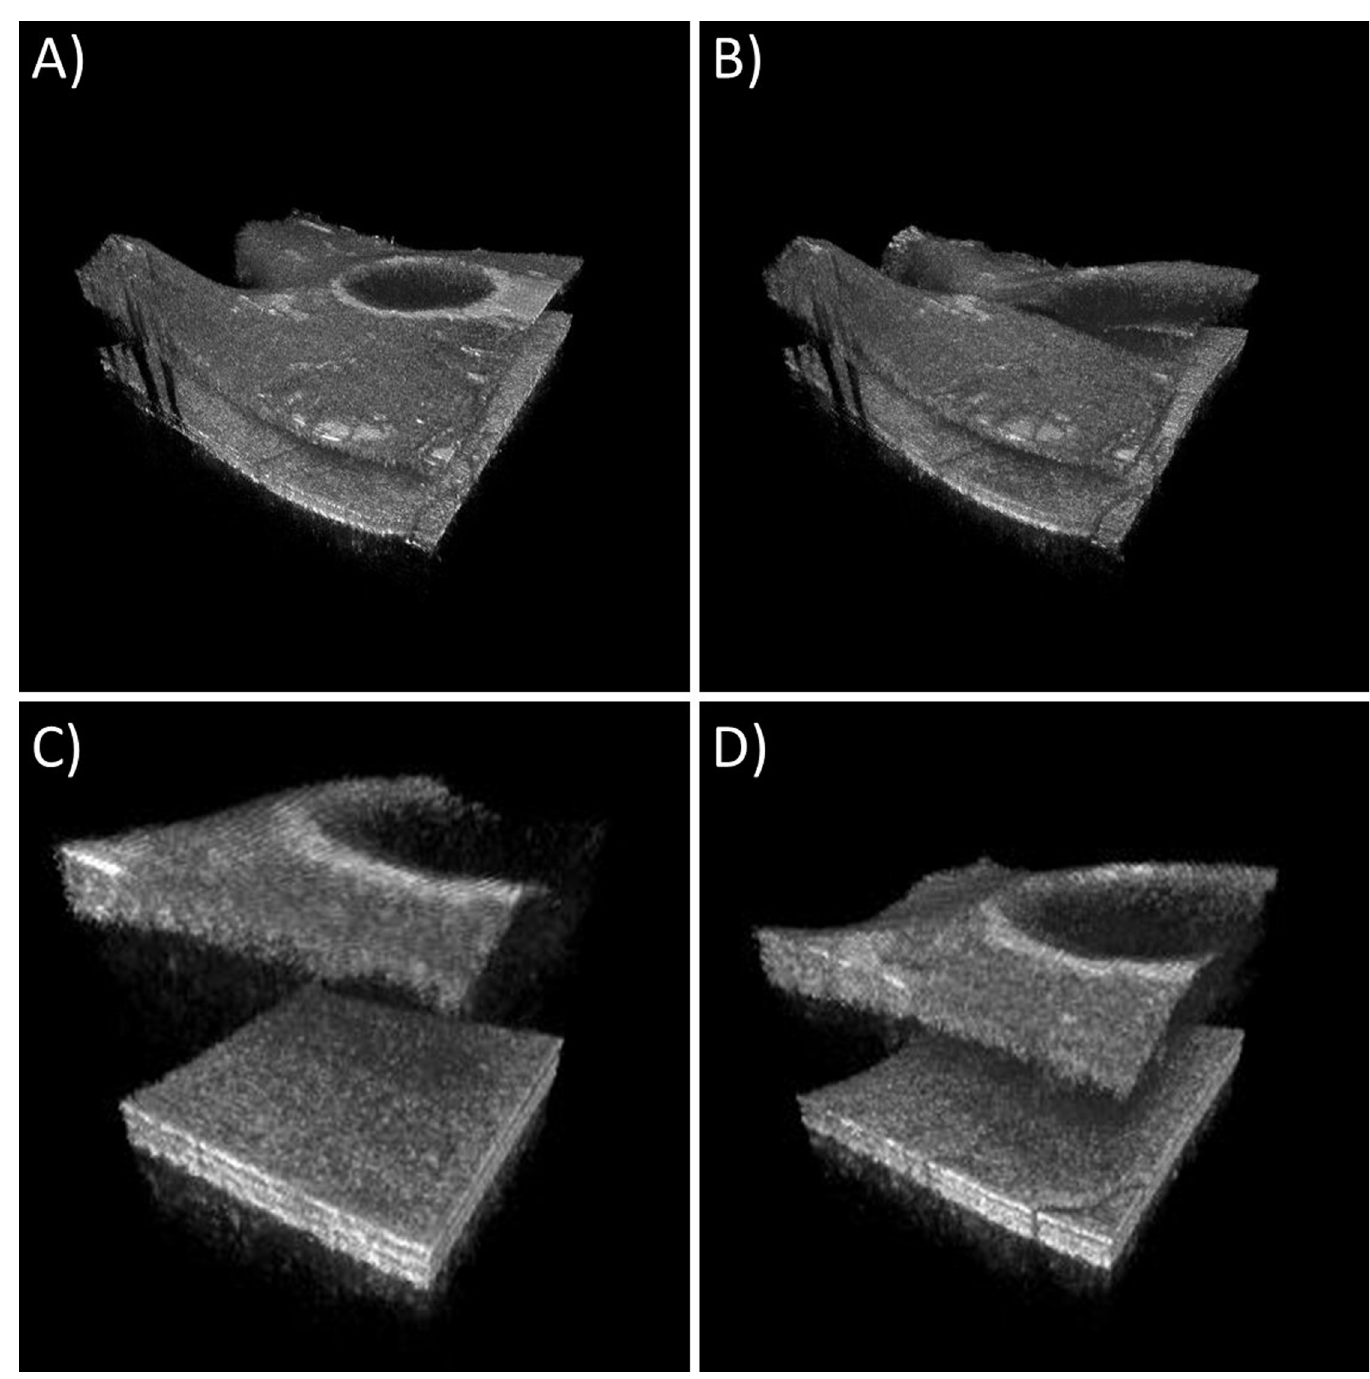
Fig 7. Comparison of original 3.34 MHz A-scan rate recording with simulations of one eighth of the original speed. A) 330 × 330 A-Scans and 24 V/s original speed (S9 Video). B) 330 × 330 A-scans and 3 V/s (S10 Video). C) 117 × 117 A-scans and 24 V/s (S11 Video). D) 165 × 165 A-scans and 12 V/s (S12 Video).